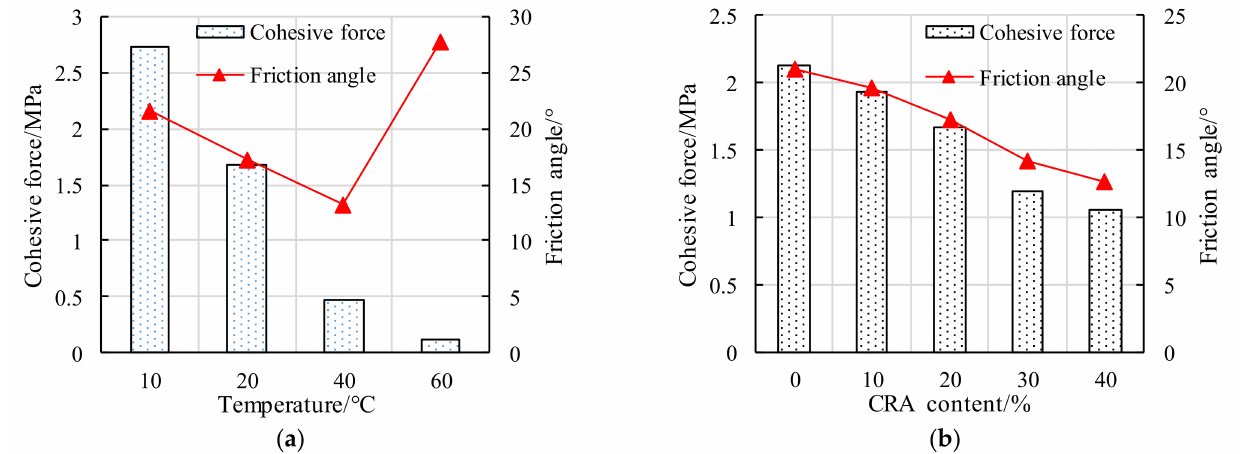
Figure 8. Mohr-Coulomb strength with ( a ) different temperatures and ( b ) CRA